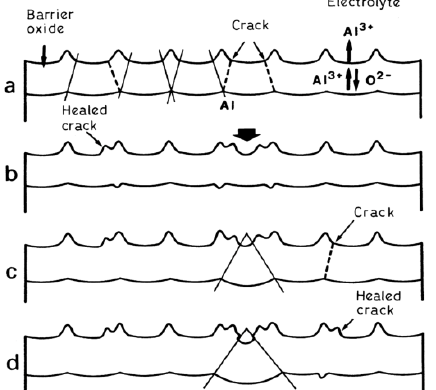
Figure 19. A schematic diagram showing the stages of pore development during anodizing (as proposed in the model by Thompson et al.). Reproduced with permission from [136]. Copyright 1997 Elsevier.